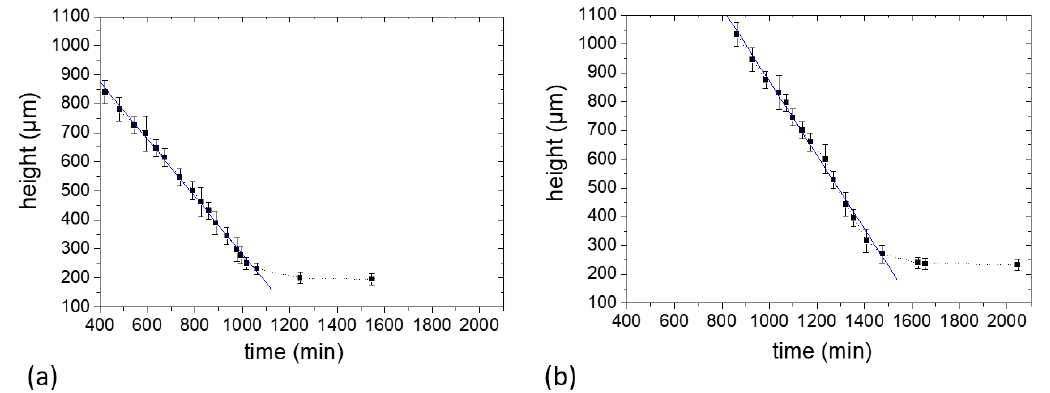
Figure 4. Film thickness estimated from the profile widths in Figure 3 as a function of drying time. Linear fits Table 1. ( a ) Sample c containing 1% starch in H 2 O ( w / v ) and ( b ) Sample d containing 5% starch in H 2 O ( w / v ). Each sample contained glycerol (20 g / 100 g of starch) as a plasticizer.